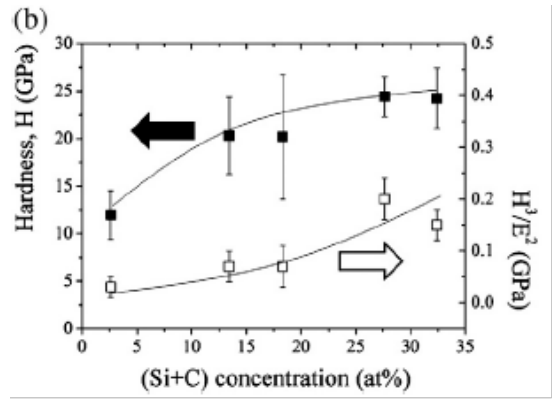
Figure 26: Hardness and H 3 /E 2 variation with (Si +C) content